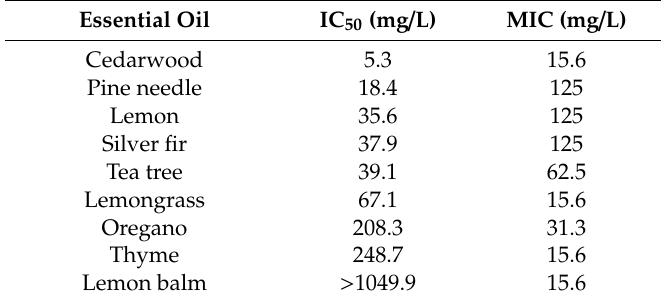
Table 4. Antibacterial activity (MIC) and inhibition of H. pylori urease (IC 50 ) by analyzed essential